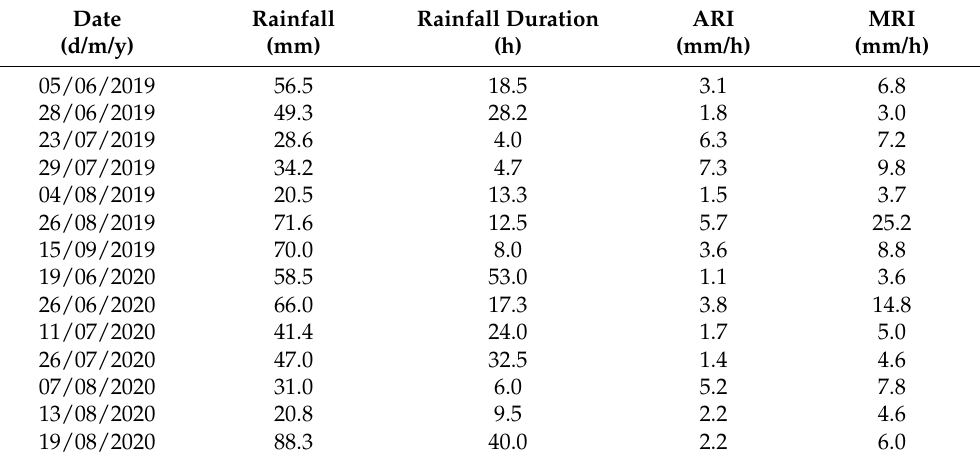
Table 2. Erosive rainfall characteristics during the study period.